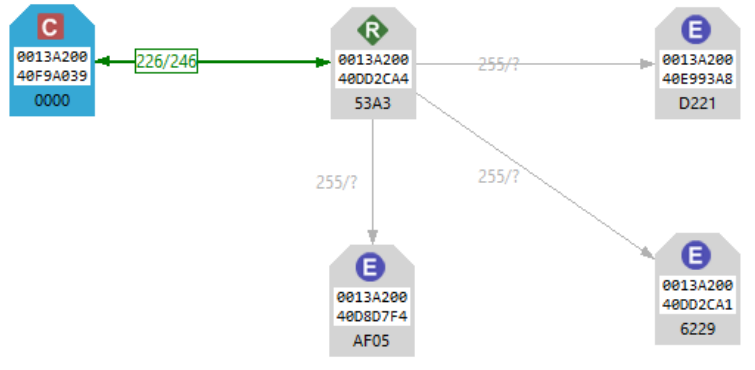
Figure 16. Network topology with an available router.